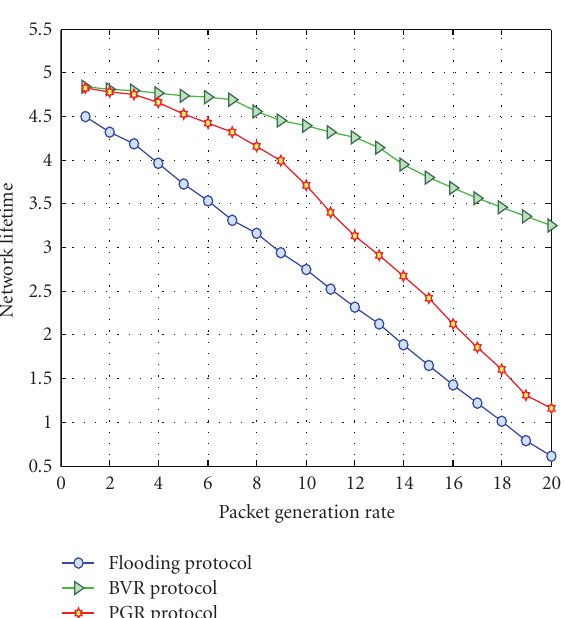
Figure 15: Energy test.